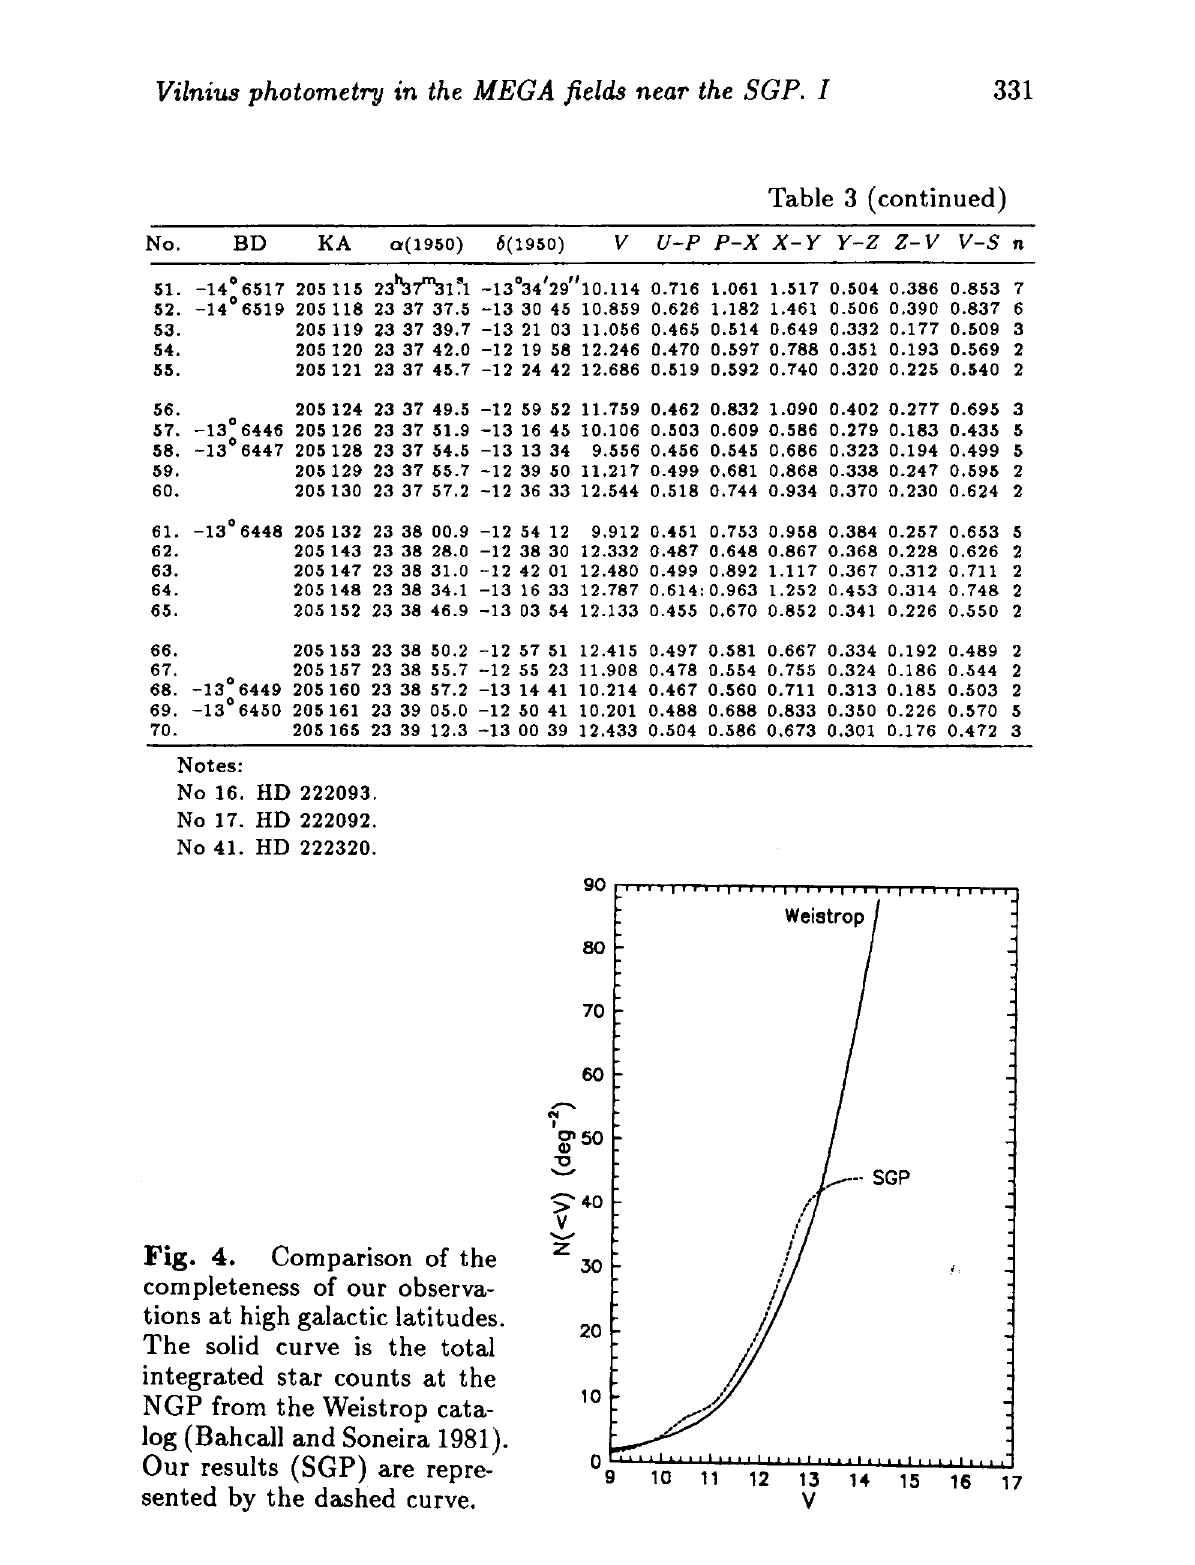
Fig. 4. Comparison of the completeness of our observa- tions at high galactic latitudes. The solid curve is the total integrated star counts at the NGP from the Weistrop cata- log (Bahcall and Soneira 1981). Our results (SGP) are repre- sented by the dashed